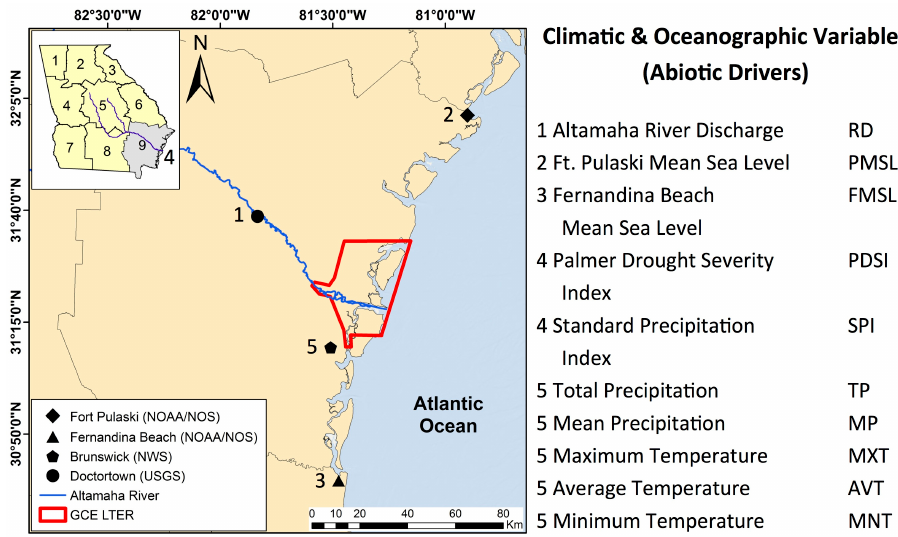
Figure 4. Map of Georgia Coast highlighting long-term monitoring stations and the ten abiotic drivers used in our study, along with abbreviations used in subsequent graphics.